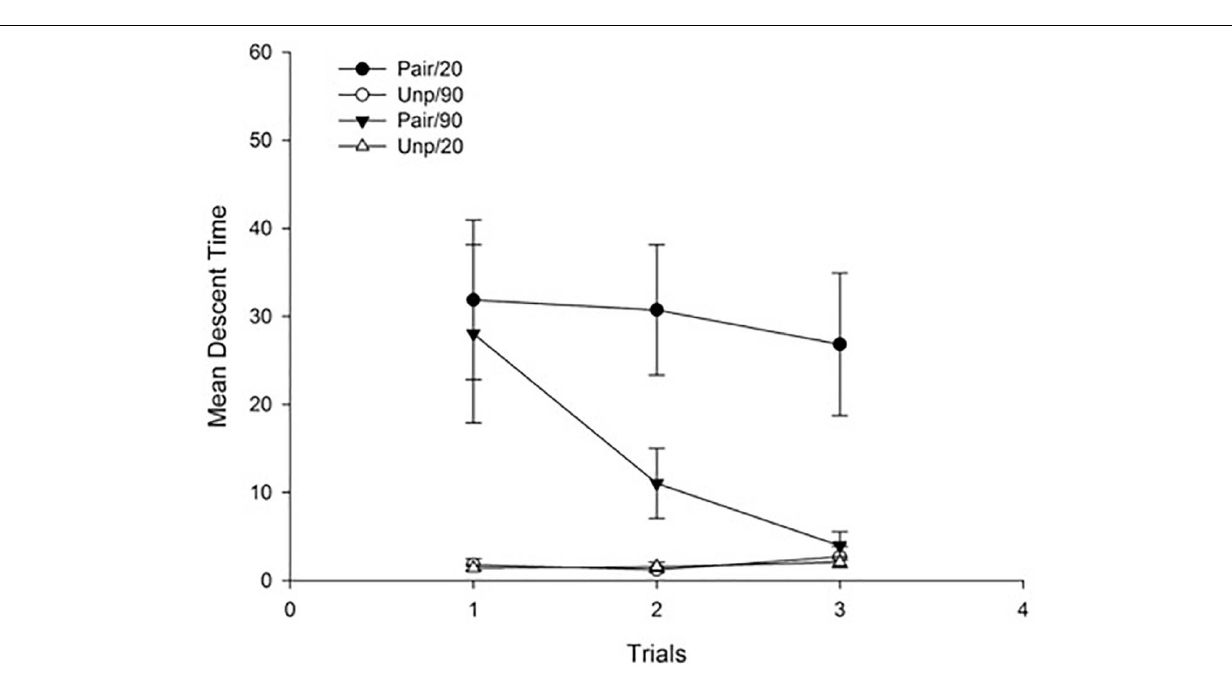
56) = 7.66; p < 0.01, η 2 = 0.22, reflects an overall decrease groups. The Trials × ISI interaction, F (2, 56) = 3.41; p < 0.05, η